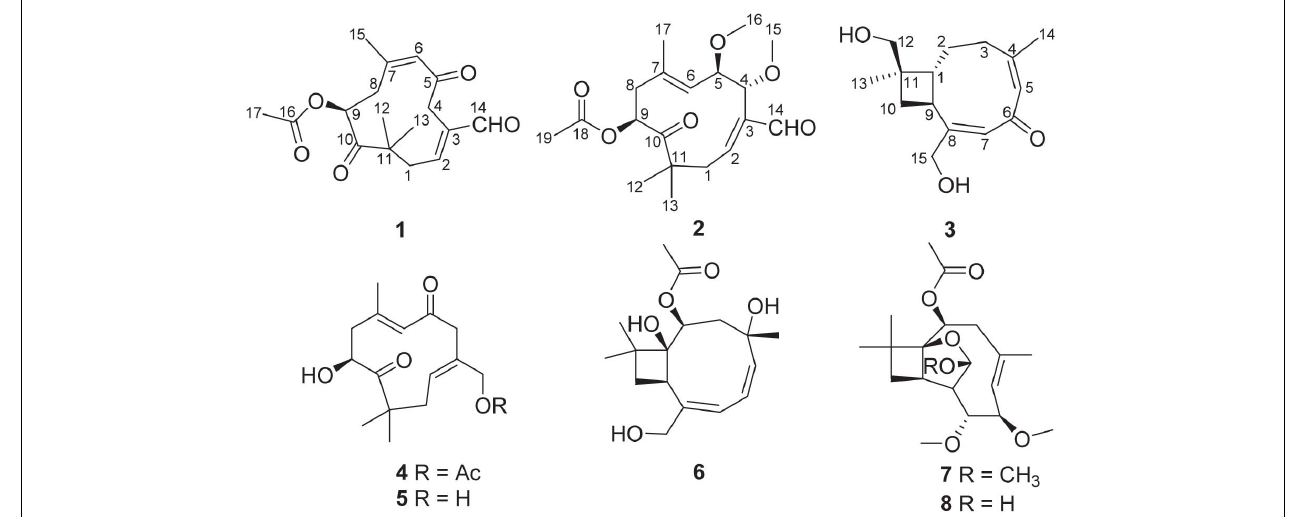
FIGURE 1 | Chemical structures of compounds 1–8 .